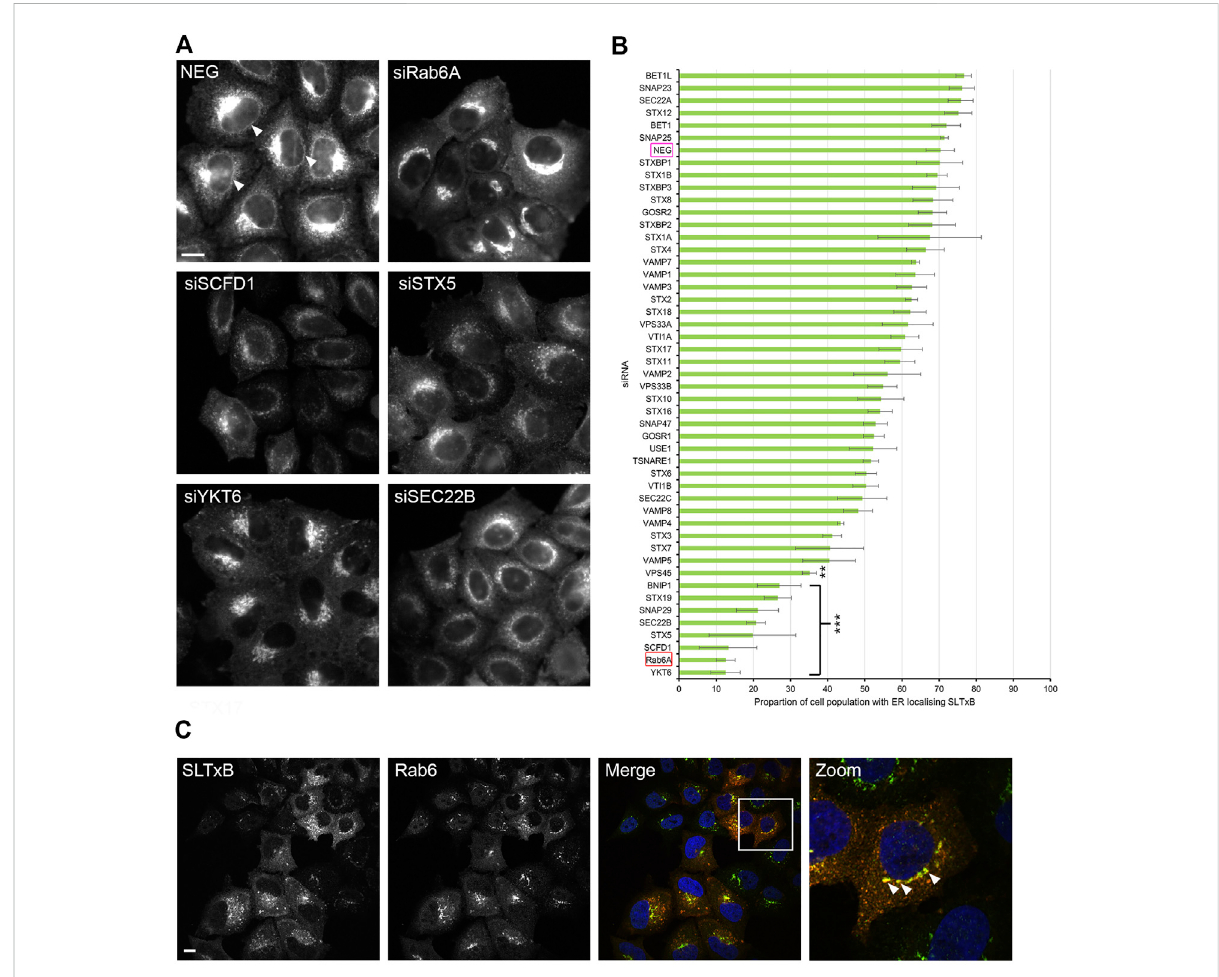
FIGURE 5 SLTxB traf fi cking assay. Cells were transfected with siRNAs for 48 h followed by incubation with SLTxB-Cy3 for 4 h at 37 ° C, and then fi xed and stained with 0.2 μ g/ml Hoechst 33342. (A) Representative images of negative control (NEG) and positive control (siRAB6A) cells as well as cells showingvariousSLTxBdistributionsthatdifferedfromthoseseenoncontrolcells,followingthesiRNAtreatmentsasindicated.Arrowheadshighlight the nuclear envelope SLTxB signal, indicating toxin arrival at the ER. Scale bar: 10 µm. (B) Quantitative analysis of the SLTxB assay. The x-axis represents the percentage of the cell population with an ER localising SLTxB signal, and the y-axis represents each siRNA treatment. The magenta box highlights the negative control (NEG), and the red box highlights the positive control (Rab6A). Data are represented as the mean ± SEM of three independent experiments. An Anova test with a Bonferroni post-hoc test was performed against the NEG controls. P < 0.01 **, p < 0.001 ***. (C) Representative images of cells depleted for SCFD1, showing strong co-localisation between SLTxB (red) and Rab6 (green) Arrowheads highlight punctate structures positive for both SLTxB and